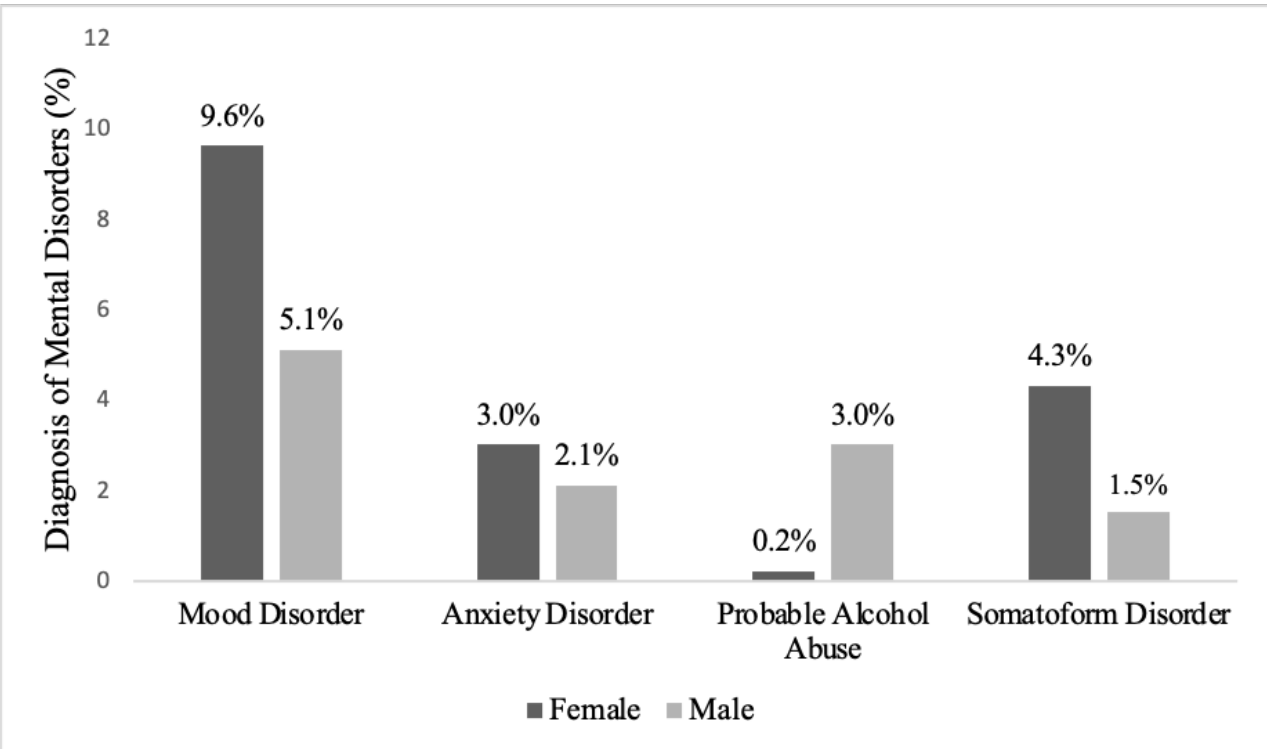
Figure 2. The distribution of mental disorders was obtained from the PRIME MD modules according to sex.